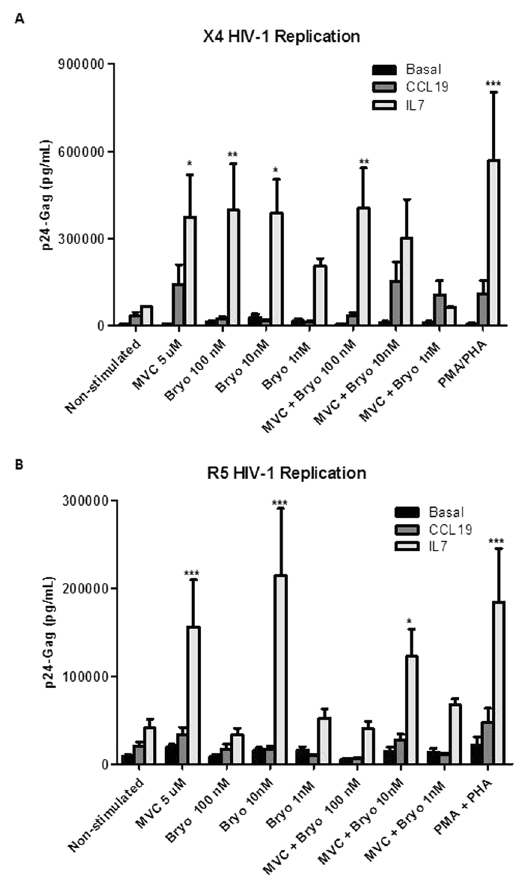
Figure 3. HIV-1 replication in rCD4 + T cells treated with MVC alone or in combination with Bryostatin-1. Primary rCD4 + T cells were treated with CCL19 or IL-7 for 5 days, then infected with X4-tropic NL4–3 strain ( A ) or with R5-tropic BaL strain ( B ) and cultured for 5 additional days. MVC (5 μ M) or Bryostatin-1 at indicated concentrations were added alone or in combination during the last 18hr. Stimulation with PMA/ PHA was used as positive control. HIV-1 replication was assessed by quantifying p24/Gag levels in the culture supernatant. Statistical significance was calculated using two way ANOVA with Bonferroni post-test analysis ( * p < 0.05, ** p < 0.01 and *** p < 0.001). Data shown are mean ±